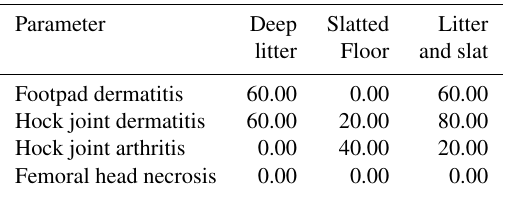
Table 4. The prevalence of footpad dermatitis, hock joint dermati- tis, hock joint arthritis, and femoral head necrosis